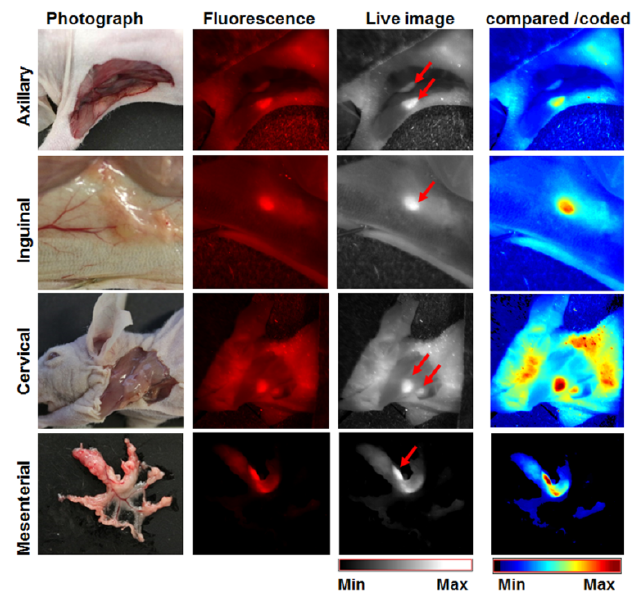
Figure 8. Bispecific liposomes enable demarcation of swollen lymph nodes in tumor-bearing mice. Mice bearing the HT1080-hFAP tumors were sacrificed and dissected 24 h post injection of 20 µ mol (final lipids) Bi-FAP / mEnd-IL / kg body weight of the mice. The figure depicts representative photographs, fluorescence and live images showing the swollen axillary, inguinal, cervical and mesenterial lymph nodes, and the corresponding intensity scaled image acquired after comparison of the fluorescence intensities. Red arrows on the live images point at the clearly distinguishable lymph nodes.